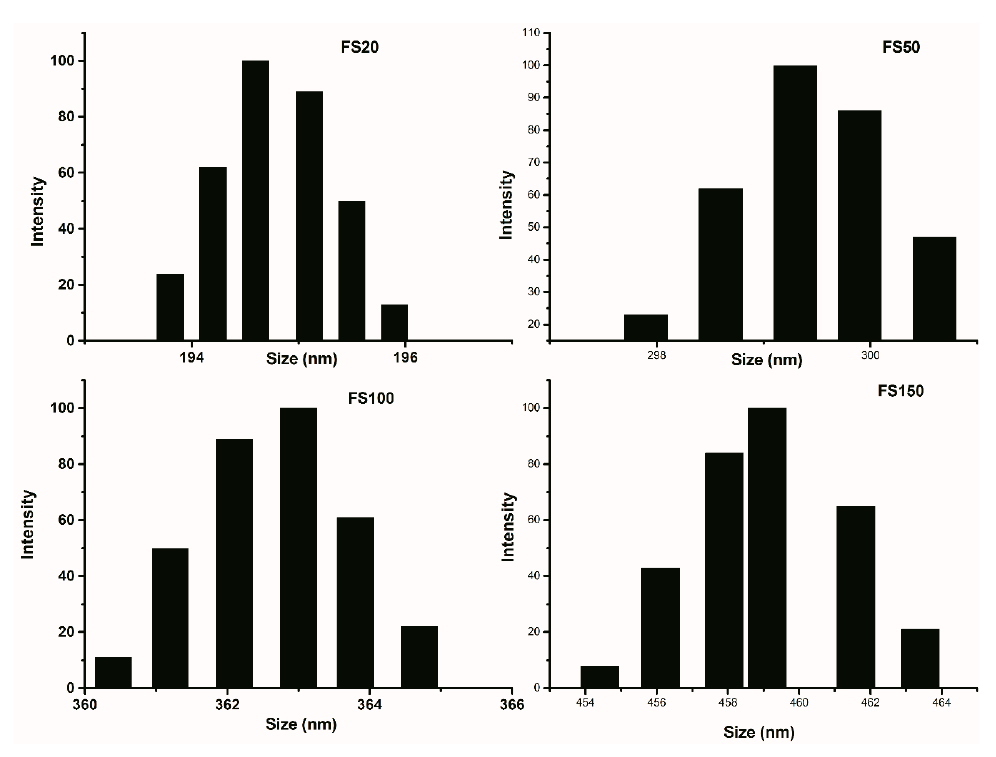
15 cm from the burner.